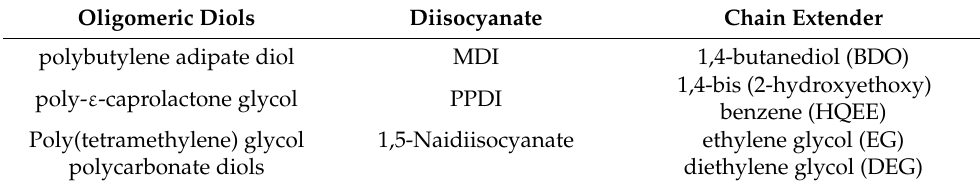
Table 1. Raw materials suitable for TPU elastomer synthesis. Oligomeric Diols Diisocyanate Chain Extender polybutylene adipate diol MDI 1,4-butanediol (BDO) poly- ε -caprolactone glycol